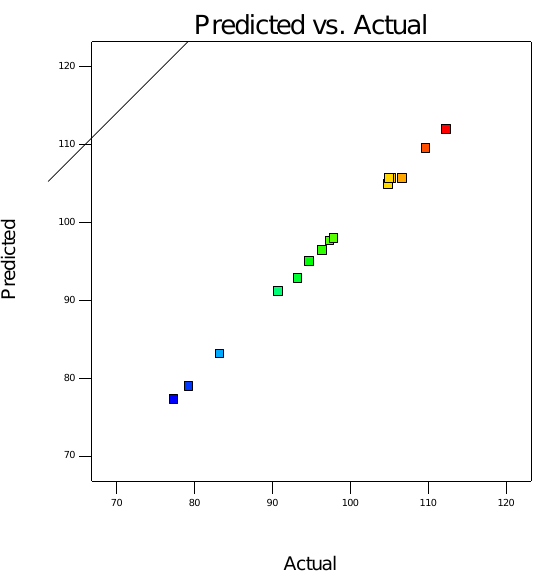
Figure 3. The corresponding relationship between the actual value and the predicted value.